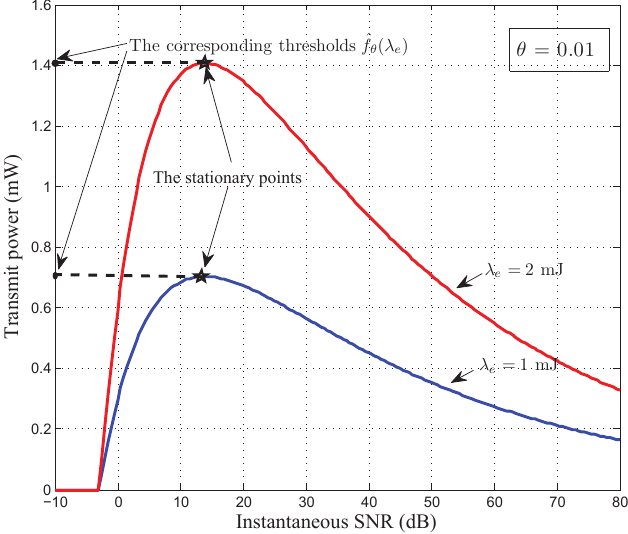
Figure 4. The transmit power curves versus instantaneous SNR to show the threshold ˆ f θ ( λ e ) under θ =